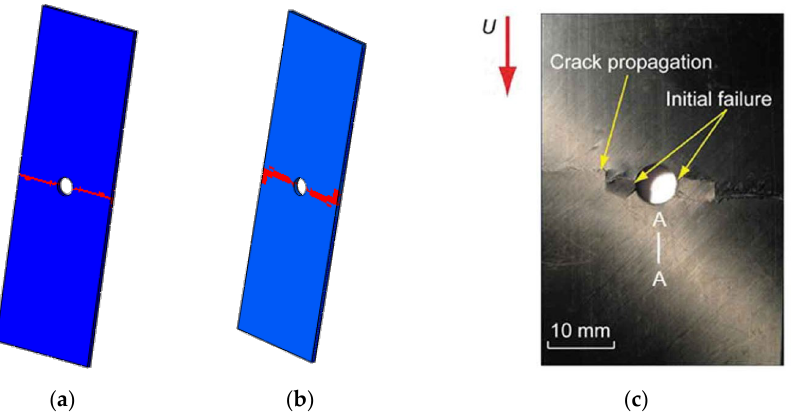
Figure 26. Final failure areas of fiber and matrix. ( a ) fiber failure; ( b ) matrix failure; ( c ) experimental